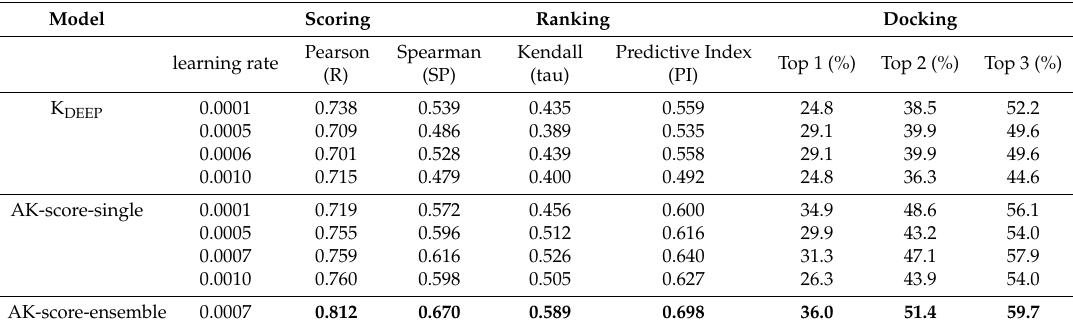
The highest values are shown in